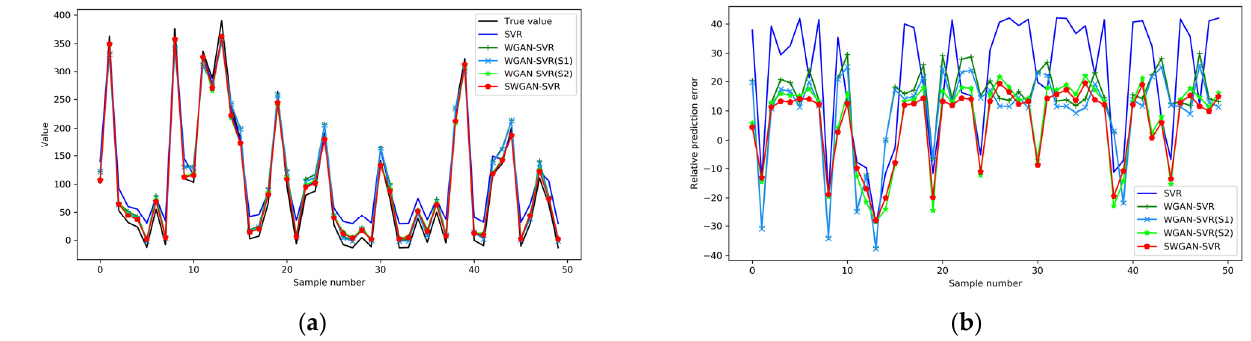
Figure 6. Prediction performance of five methods for the numerical example: ( a ) the assay and predicted values, and ( b ) the relative prediction errors.